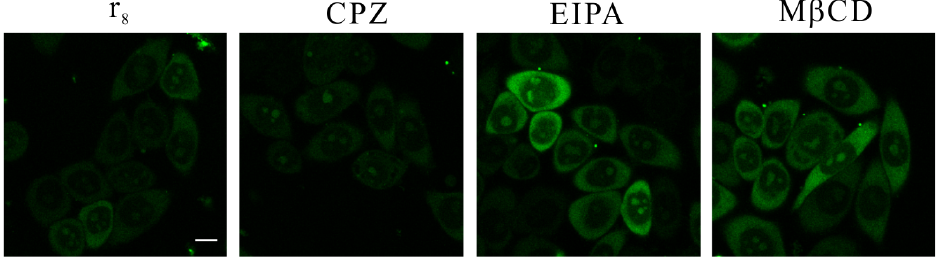
Fig. 4. The uptake of FITC-r 8 is independent of endocytosis. HeLa cells were treated with the indicated inhibitor for 30 min at 37 (cid:2) C or remained untreated, followed by incubation for a further 5 min with FITC-r 8 (5 (cid:1) M) in the absence or presence of the respective inhibitor. Scale bar: 10 (cid:1) m.